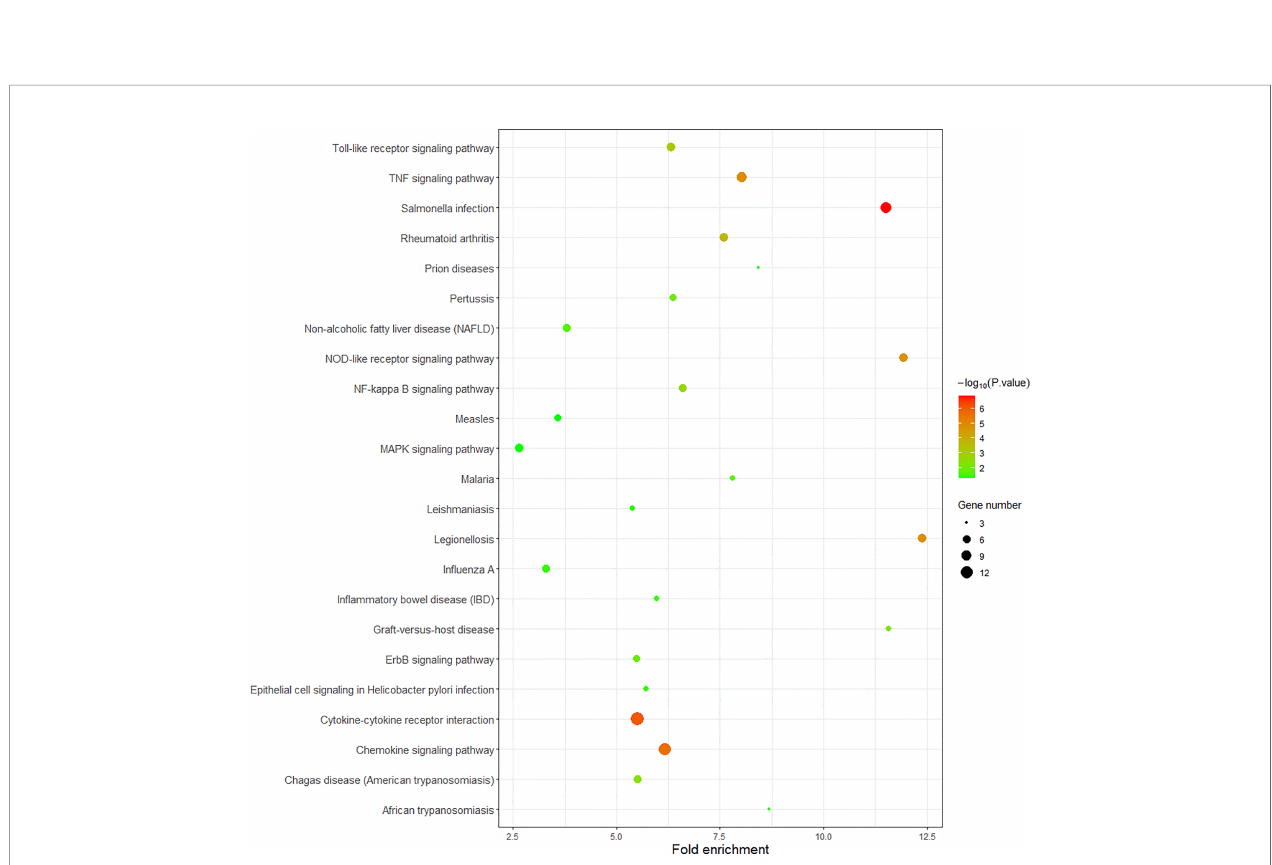
FIGURE 4 | The results of KEGG of DEGs.